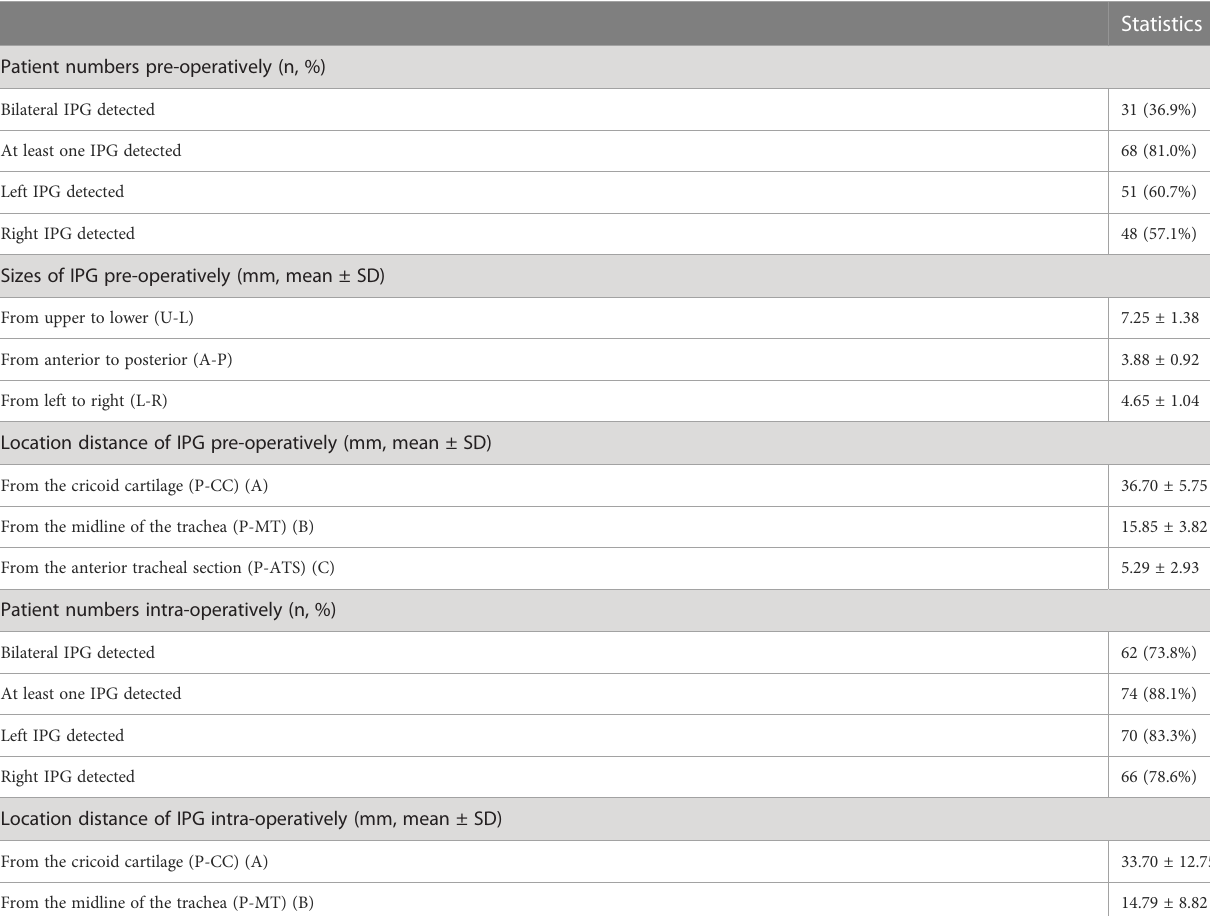
TABLE 2 Details of pre-operative ultrasound evaluation and intra-operative detection of IPG in PUS